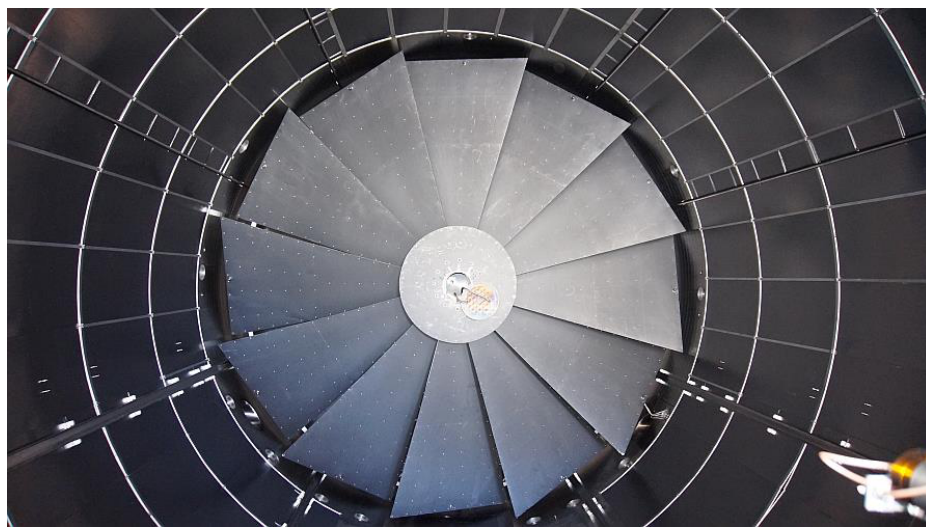
Figure 2: STG-ET beam dump target installed at the vacuum chamber end wall, and the coating of the cylindrical vacuum chamber